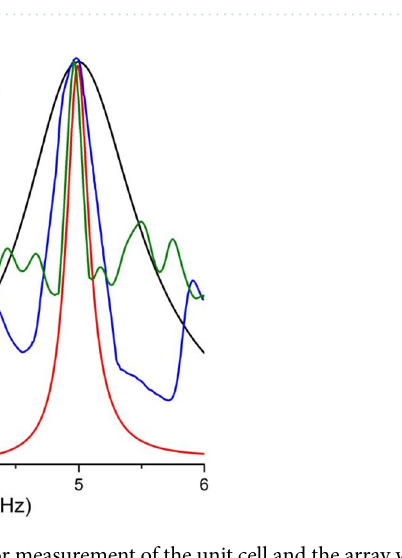
Figure 12. Comparison of absorption for measurement of the unit cell and the array with that of